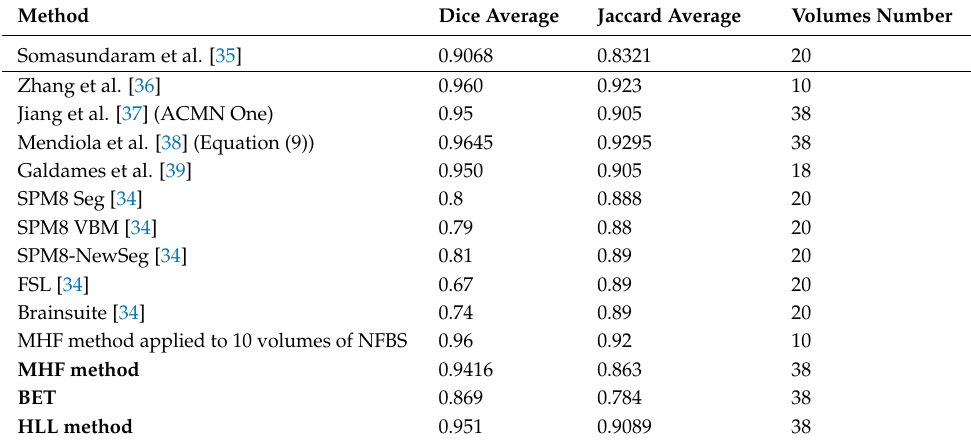
Table 4. Jaccard and Dice indices mean values reported in the literature.